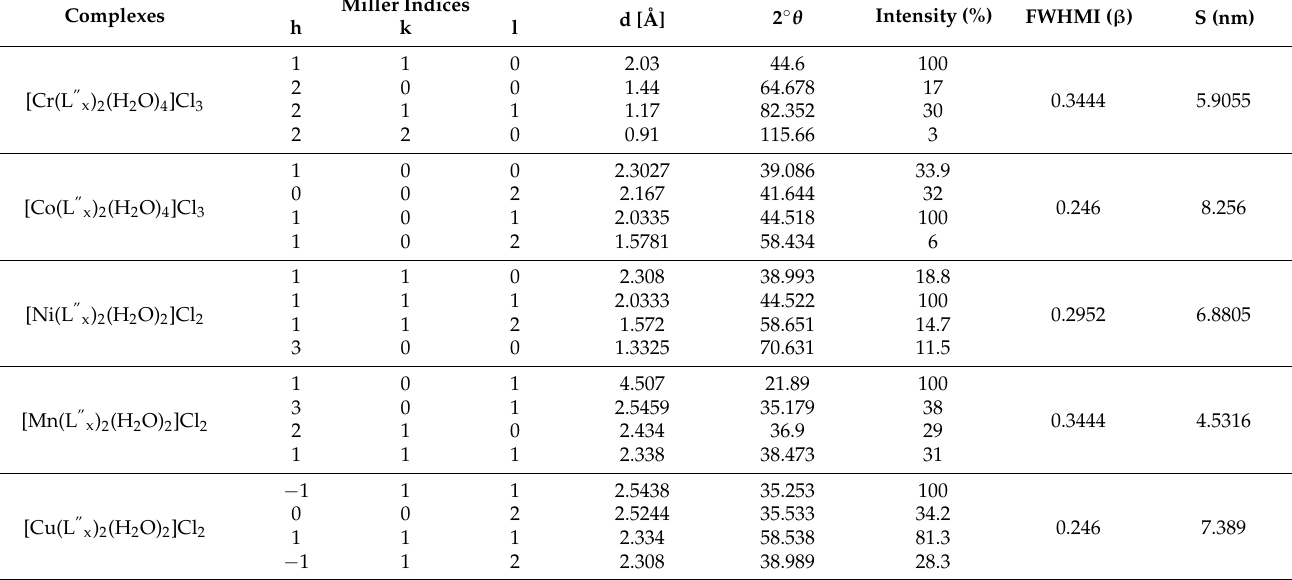
Table 5. Crystal lattice Data and Summary of Data Collection and Refinement for Compounds 4 – 8 . Miller Complexes